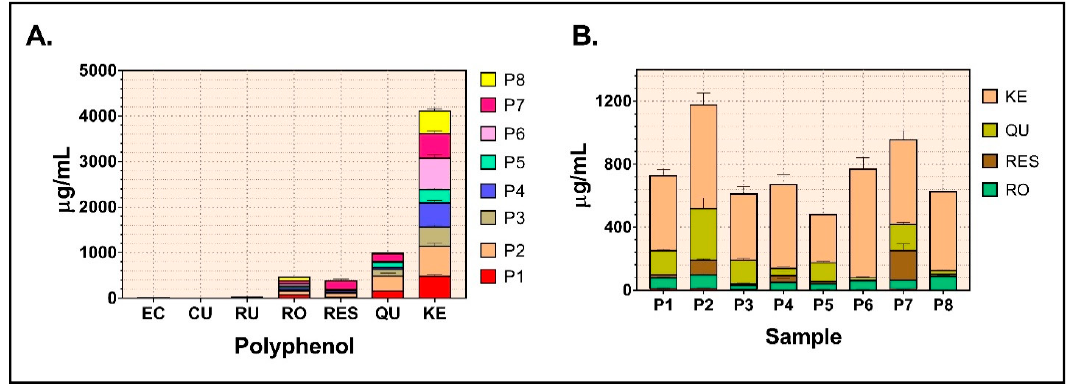
Figure 2. The individual polyphenols detected in propolis samples P1-P8 ( A ) and the main 4 phenolic compounds identified ( B ). (Data are expressed as mean ± SEM). (EC epicathechin, CU- p -coumaric acid, RU-rutin, RO-rosmarinic acid, RES-resveratrol, QU-quercetin, KE-kaempferol).